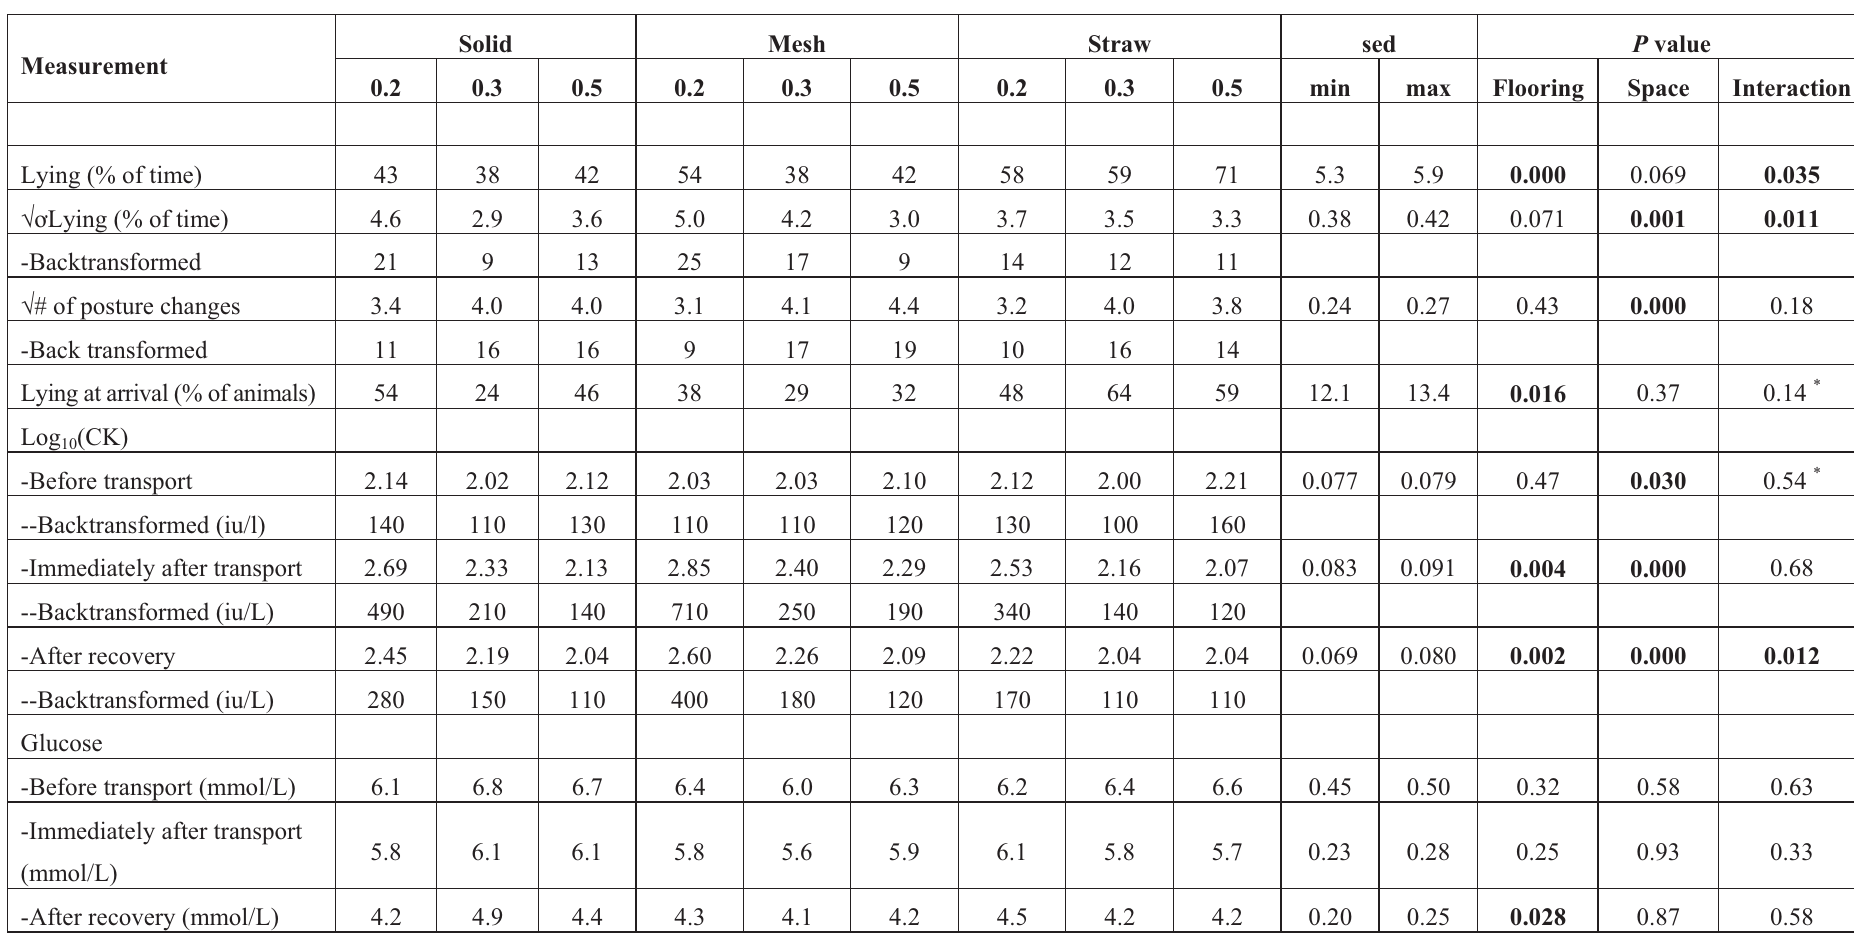
Table 3. Effect of space allowance and flooring on behaviour and physiology before, during and after transport, and after 12 h of recovery. The standard error of difference between means (sed) differs somewhat depending on which pair of predicted means is being compared, and thus the smallest (min) and largest (max) sed are presented for each measurement. The interaction P value is the P value for testing for any interaction between flooring and the space treatments. Approximate least significant differences can be calculated as the sed multiplied by